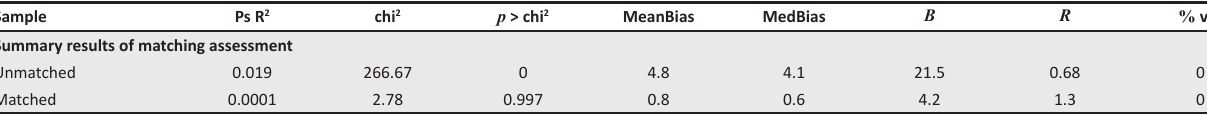
TABLE 4b: Propensity scores and summary result of matching assessment. Sample Ps R 2 Summary results of matching assessment